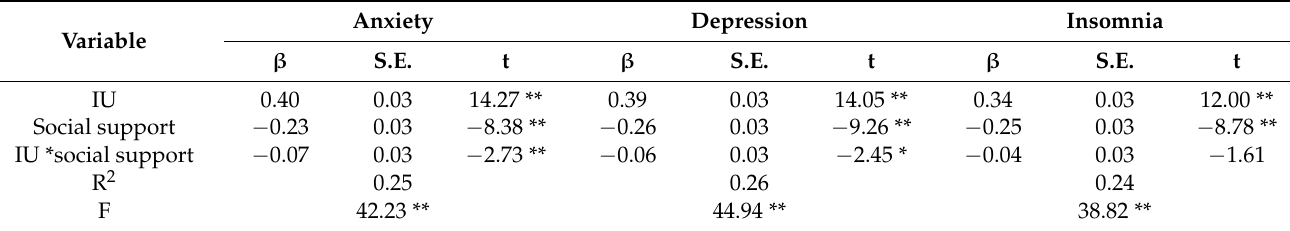
Table 4. Regression Results Using Process in